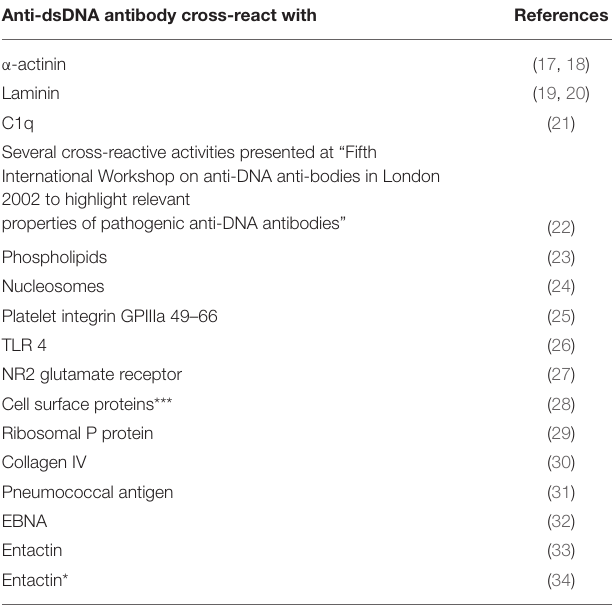
TABLE 1 | Examples of anti-dsDNA antibodies that cross-react with non-DNA structures. Anti-dsDNA antibody cross-react